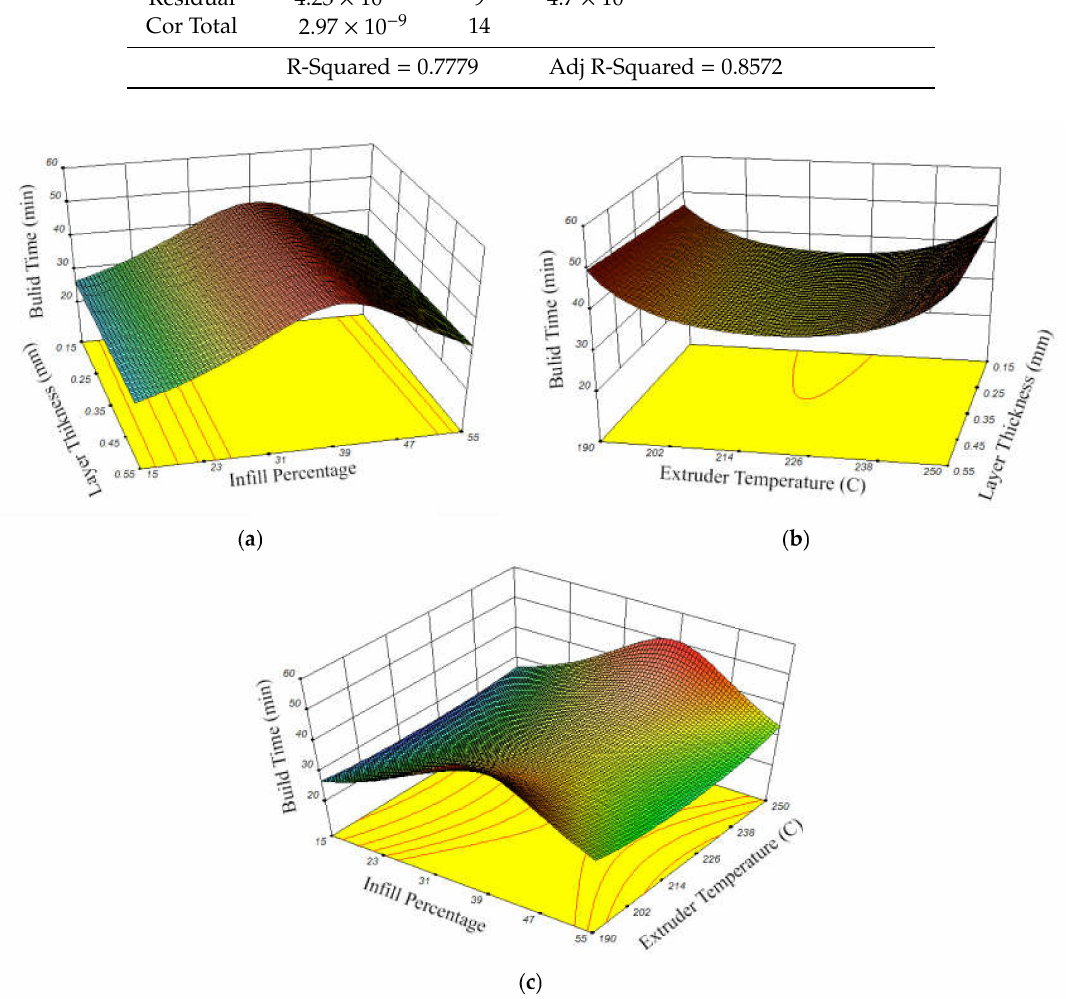
Figure 8. 3D surface plot of the build time with ( a ) infill percentage and layer thickness; ( b ) extruder temperature and layer thickness; ( c ) infill percentage and extruder